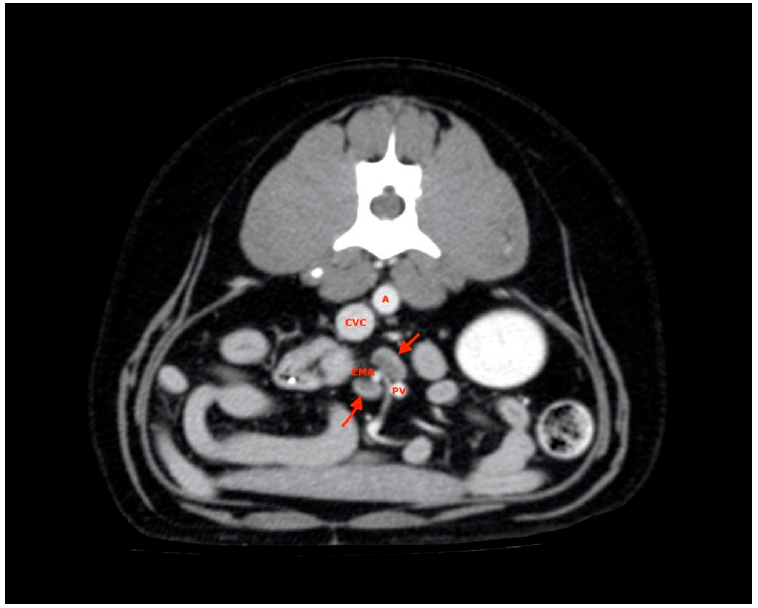
Figure 7. Jejunal lymph nodes (red arrows). A, aorta; CVC, caudal vena cava; PV, portal vein; CMA, cranial mesenteric artery.